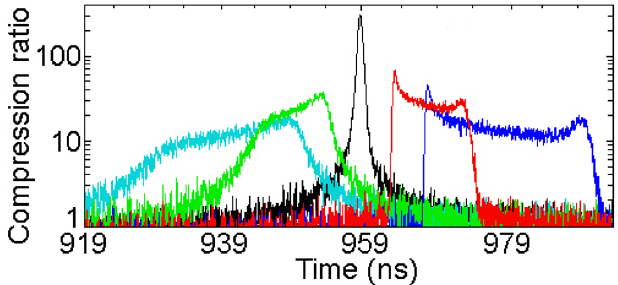
(cid:2) t (cid:3) =I FIG. 19. (Color) Compression ratio I (log scale) compari- b 0 variations using the smooth waveform son of (cid:13) 5% constant E 0 across the finite-size gap and T k (cid:4) 0 : 2 eV beams at z (cid:4) (cid:4) 420 keV (light (cid:8) 59 : 5 cm in the laboratory frame for E 0 (cid:4) 410 keV (green), E (cid:4) 400 keV (black), E (cid:4) blue), E 0 0 0 (cid:4) 380 keV (dark blue). 390 keV (red), and E 0